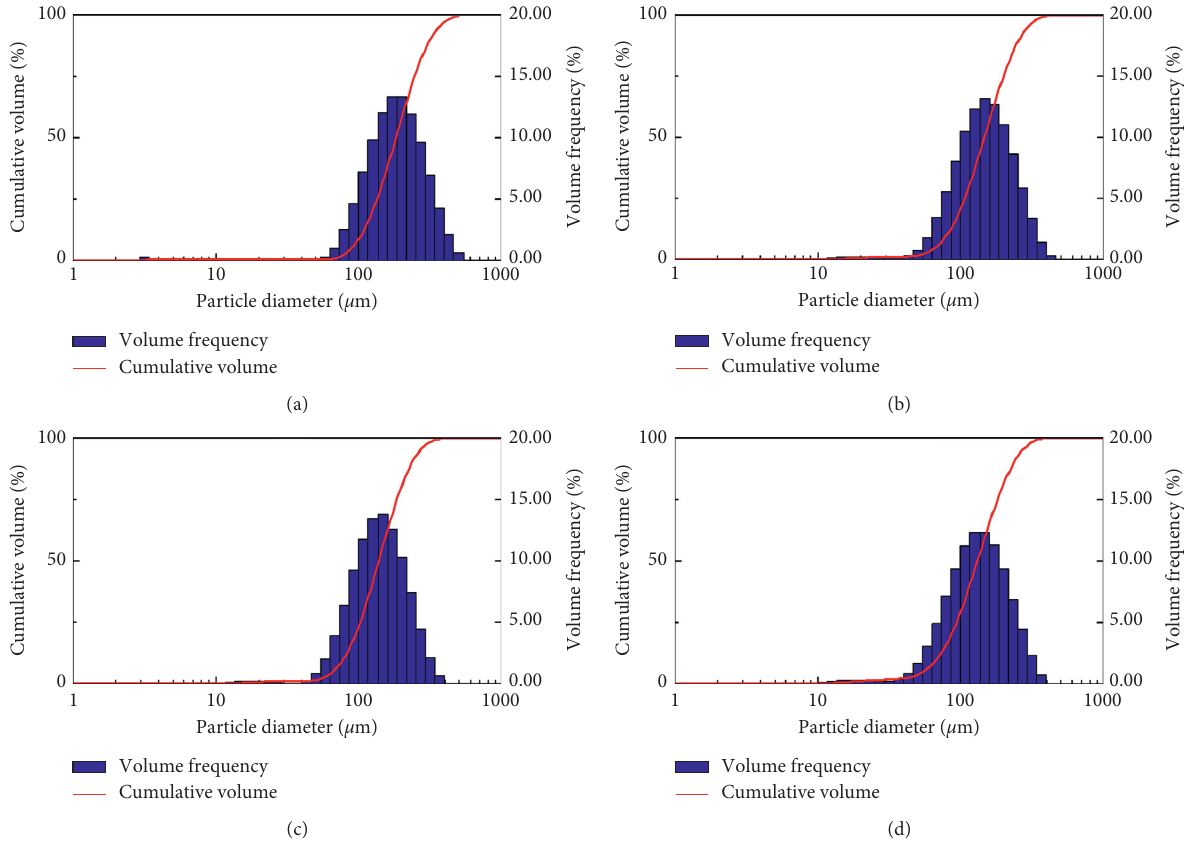
Figure 12: Distribution of droplet size under four different water-supply pressures: (a) p � 0 . 5MPa; (b) p � 1 . 0MPa; (c) p � 1 . 5MPa; (d) p � 2 .